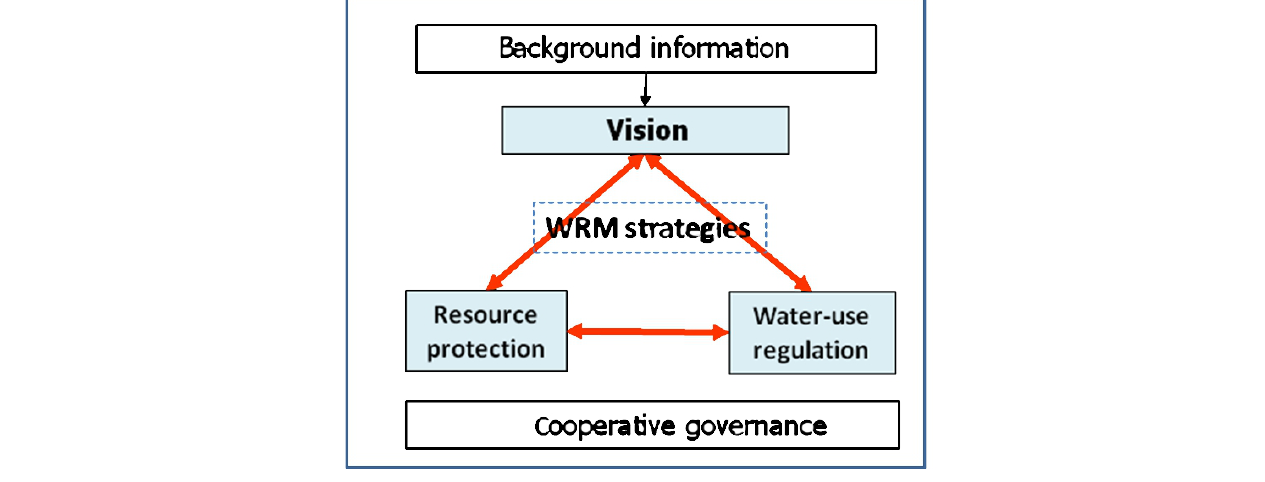
Fig. 2. Three key areas requiring stakeholder consensus and collaboration. The areas highlighted in blue require stakeholders to collaboratively define strategic plans for the management of water resources. WRM = water resources management (Du Toit and Pollard